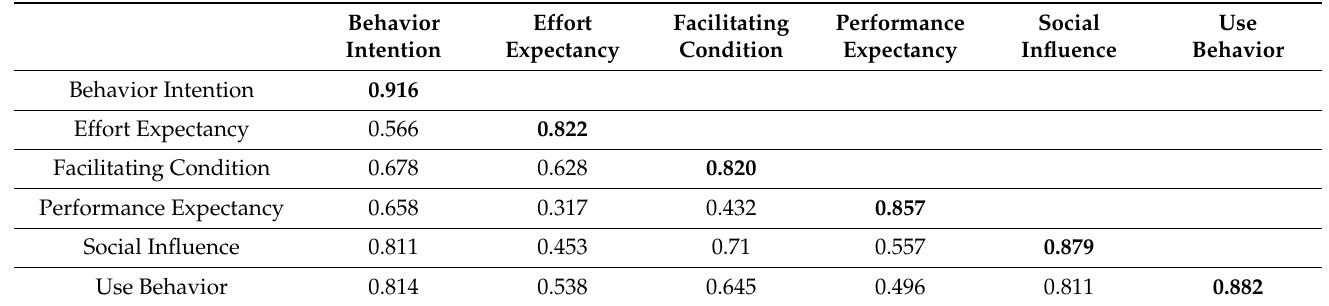
Table 5. Results of discriminant validity based on Fornell–Larcker criterion results.